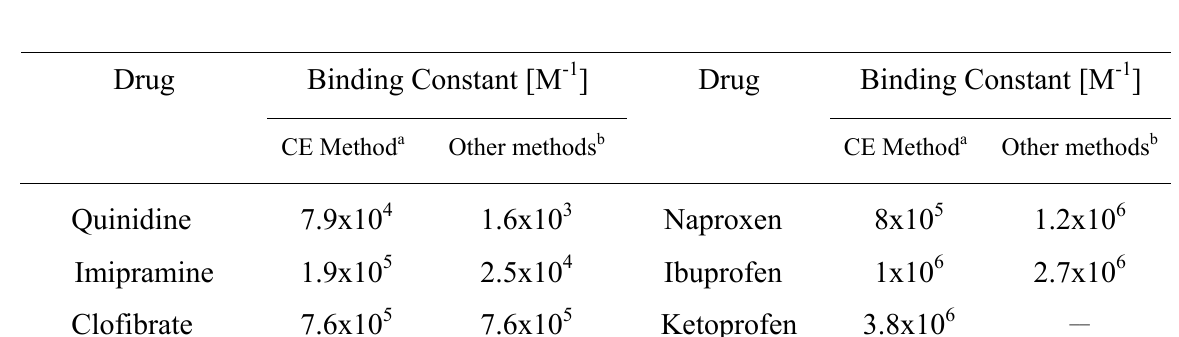
O O O clofibrate O ketoprofen